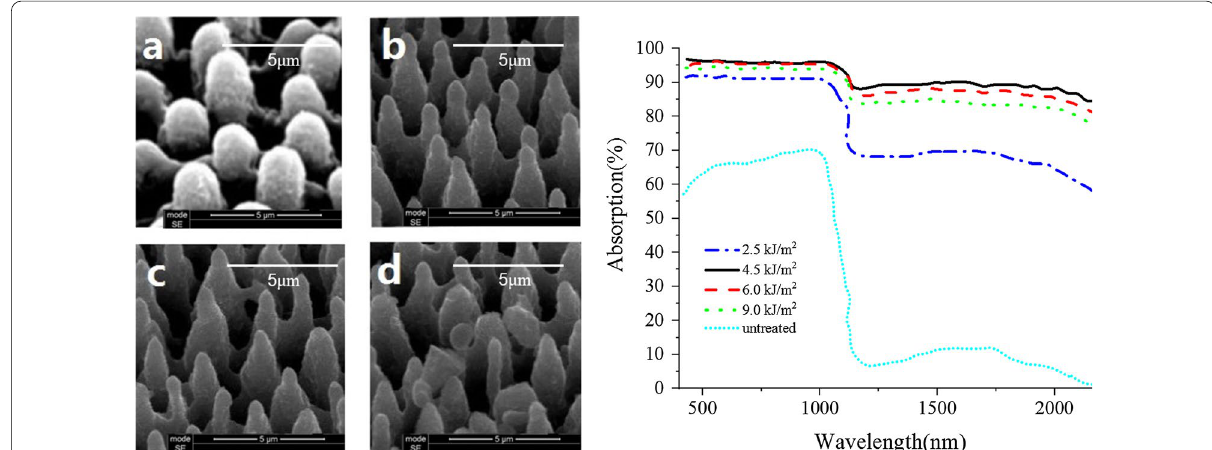
Fig. 10 The surface morphology and absorption spectra of the materials at different optical power density a 2.5 kJ/m 2 , b 4.5 kJ/m 2 , c 6.0 kJ/m 2 , d 9.0 kJ/m 2